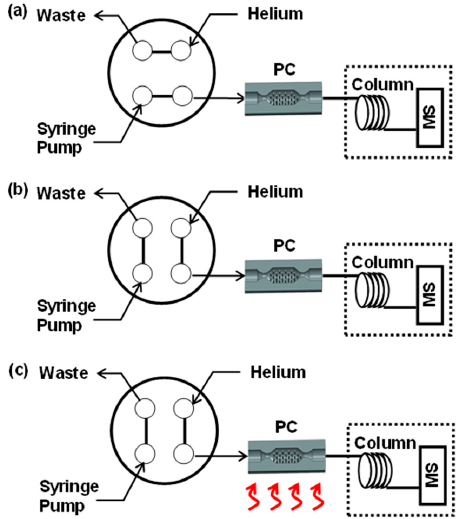
Figure 3. Schematics of sampling and injection steps using a four-port valve: ( a ) in a sampling step, a diluted toluene is trapped in a PC, ( b ) as a valve position is switched, a carrier gas of helium flushes residual toluene in the transfer lines and PC, and ( c ) thermal energy is applied to the adsorbents to release trapped toluene to GC / MS for